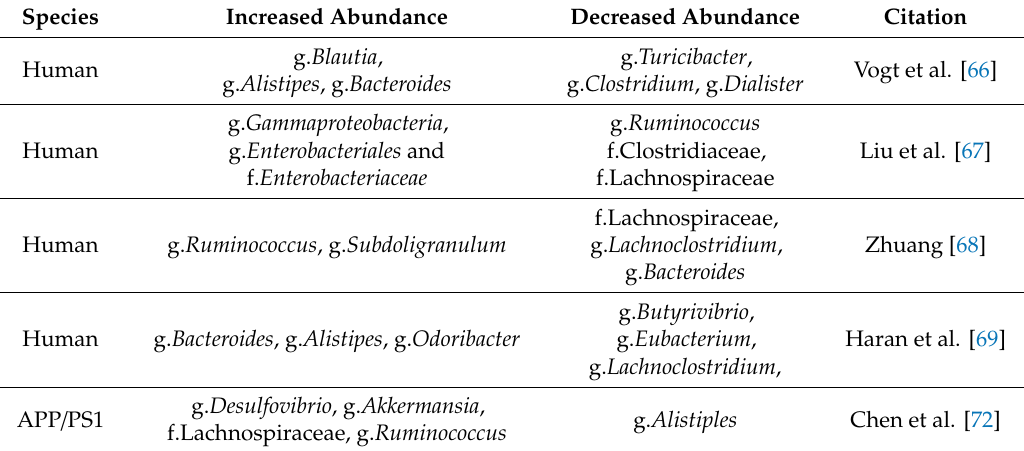
Table 1. Alterations in gut microbiota composition in humans and transgenic mice without